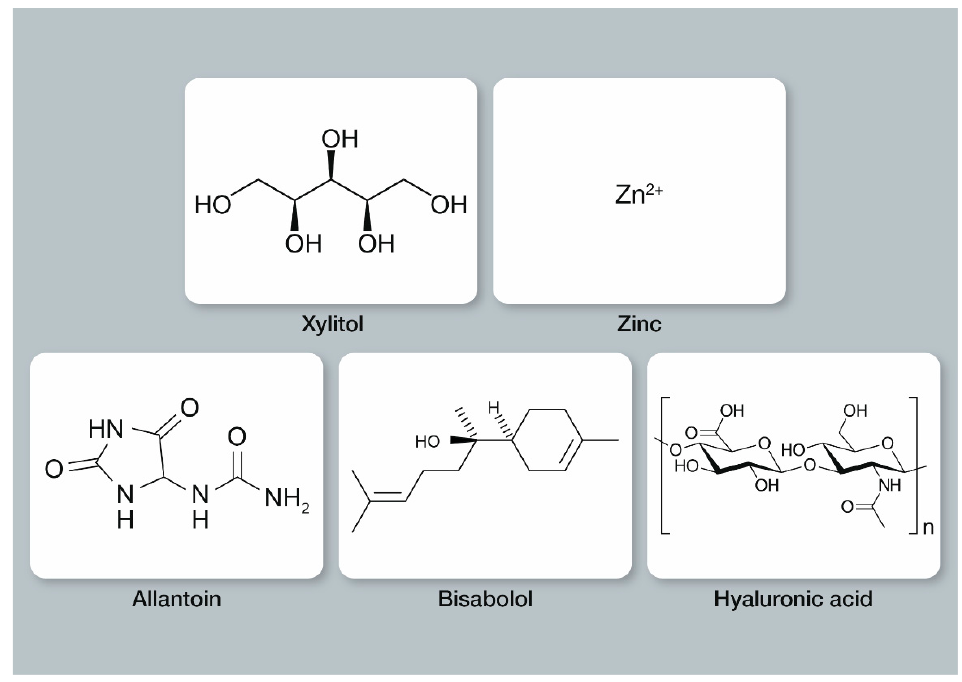
Figure 1. Structural formulas of the analyzed ingredients in this review used in combination with hydroxyapatite in oral care products (structural formulas according to ref. [20]; due to its complexity, the structure of lactoferrin is not shown; details have been published e.g., by Baker et al. [21] ).